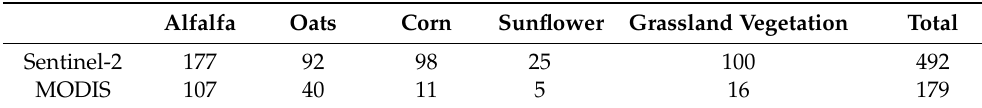
Table 1. Numbers of sampling points comprising different vegetation types. Alfalfa Oats Corn Sunflower Grassland Vegetation Total Sentinel-2 177 92 98 25 100 492 MODIS 107 40 11 5 16